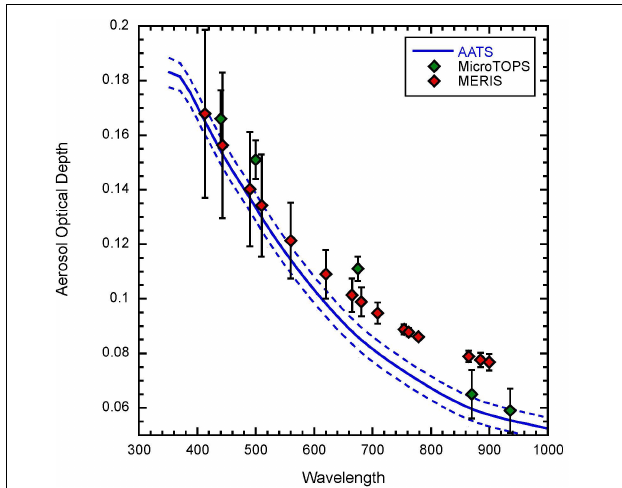
FIGURE 4 | Aerosol optical depth (AOD) derived from the average of all LSA AATS-14 measurements (blue), the average MicroTops II values for two stations, CST17 and CST18 (green), and the default MERIS AOD from SeaDAS parameters (red). Error bars indicate standard deviations for the two stations (green) and for the full MERIS image (red).